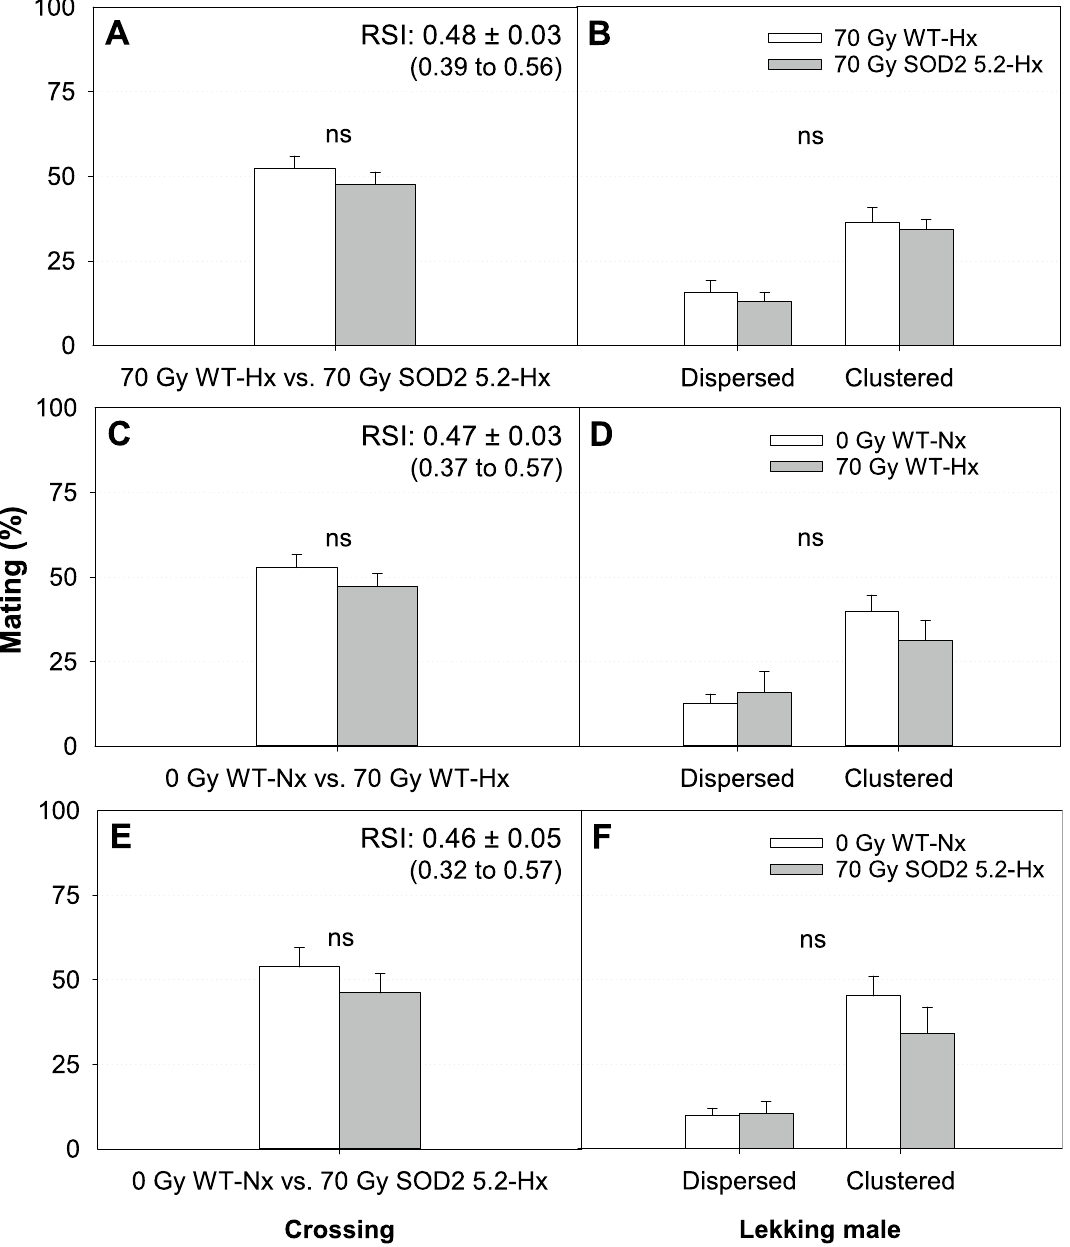
Figure 5. Mean mating success (SE) and positioning of lekking Anastrepha suspensa males treated under hypoxia (Hx) in sexual competitiveness tests with a low male: female ratio (50 males: 25 females). ( A ) Proportion of matings with WT females achieved by irradiated WT (70 Gy WT-Hx) and irradiated SOD2 5.2 (70 Gy SOD2 5.2-Hx) males. ( B ) Distribution of dispersed and clustered males within leks from matings achieved by 70 Gy WT-Hx and 70 Gy SOD2 5.2-Hx individuals. ( C ) Proportion of matings obtained by non- irradiated WT (0 Gy WT-Nx) and 70 Gy WT-Hx males competing for the same females. ( D ) Distribution of dispersed and clustered males within leks from matings achieved by 0 Gy WT-Nx and 70 Gy WT-Hx individuals. ( E ) Proportion of matings obtained by 0 Gy WT-Nx and 70 Gy SOD2 5.2-Hx males competing for the same WT females. ( F ) Distribution of dispersed and clustered males within leks from matings achieved by 0 Gy WT-Nx and 70 Gy SOD2 5.2-Hx individuals. Graphs marked with ‘ns’ indicates no statistically significant difference for either logistic regression or MANOVA models ( P > 0.05). RSI = ( ♂ SOD2 5.2 × ♀ WT)/ ( ♂ SOD2 × 5.2 ♀ WT) + ( ♂ WT × ♀ WT). Figures were created using Sigma Plot (SigmaPlot for Windows